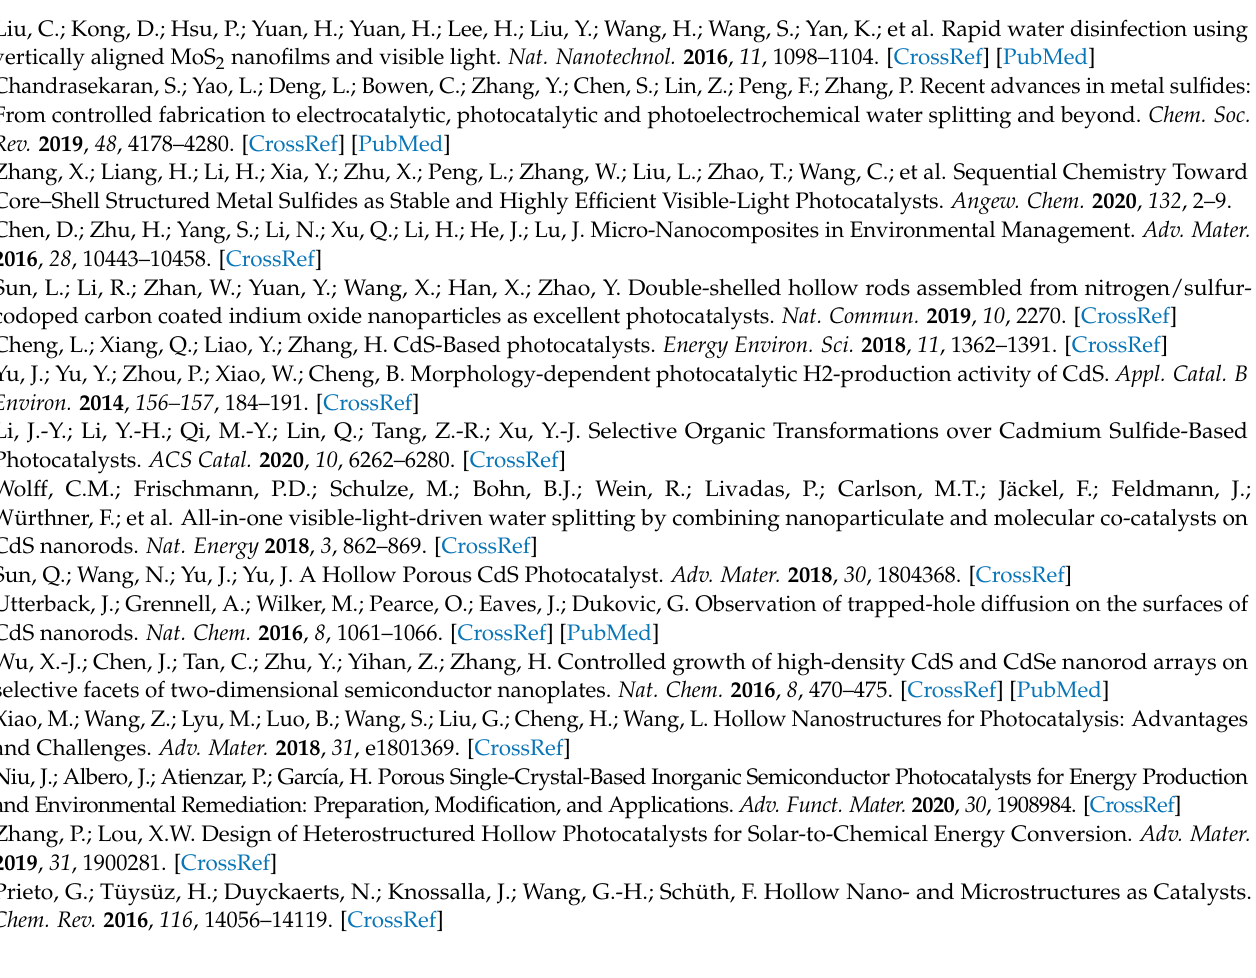
rods. Figure S2: SEM image of CdS SSs. Figure S3: Tauc plots of the CdS HRs. Figure S4: N 2 adsorption–desorption isotherms for CdS MRs and CdS HRs. Figure S5: (a) XRD pattern and (b) TEM image of the CdS HRs after the cycling